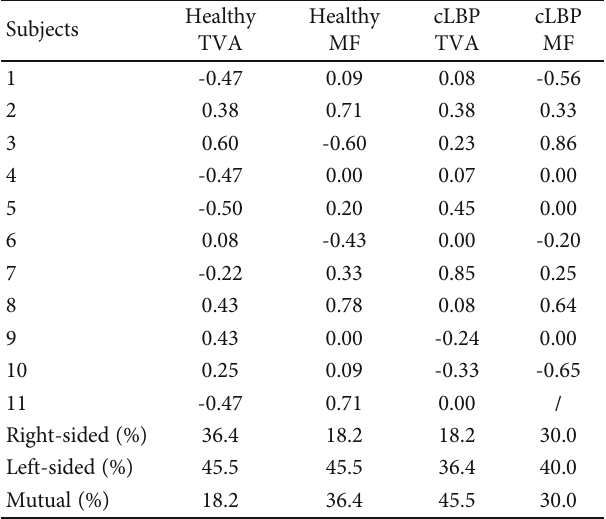
Table 3: TVA and MF muscle dominant hemispheres in healthy and cLBP